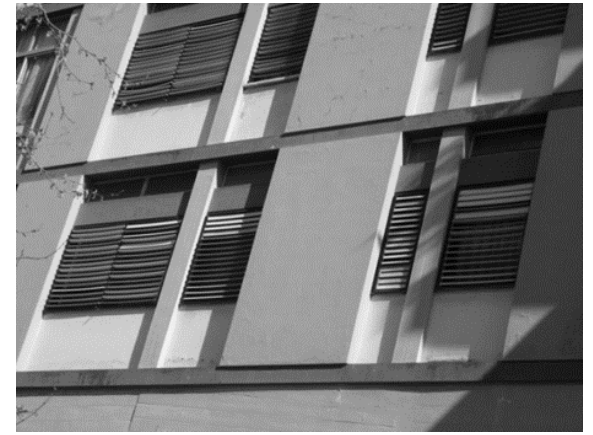
Figure 15. Rear façade. Detail of the windows.